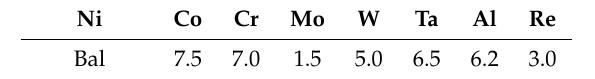
Table 2. Nominal composition of the N5 nanocrystalline coating (wt.%). Ni Co